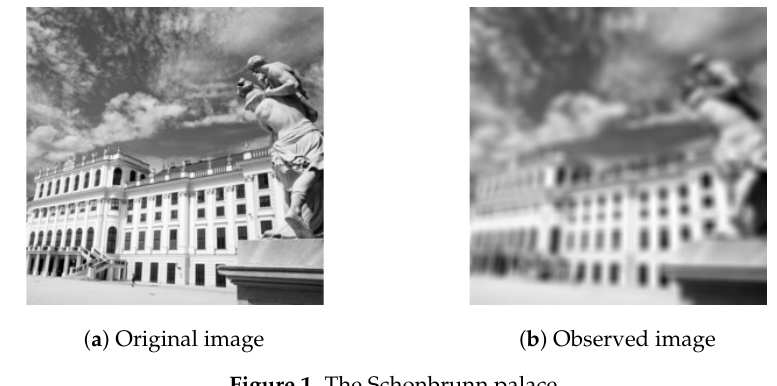
Figure 1. The Schonbrunn palace.